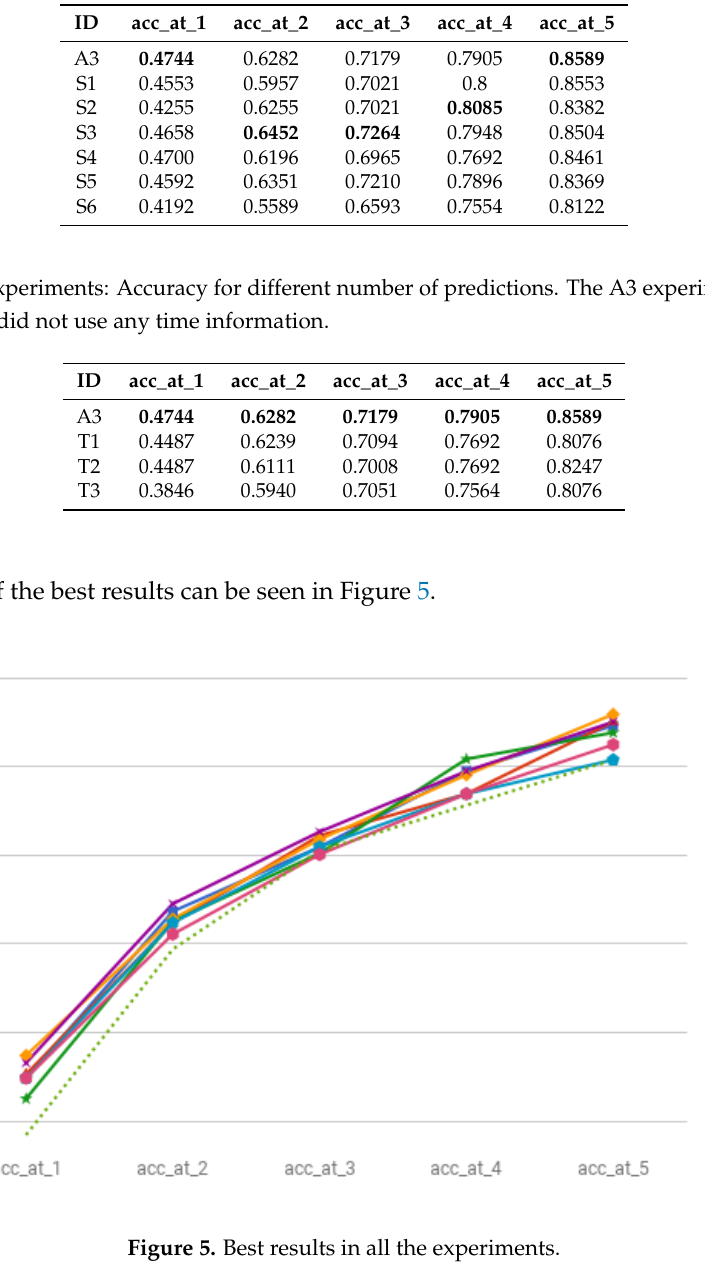
Table 4. Sequence-length experiments: Accuracy for different number of predictions.